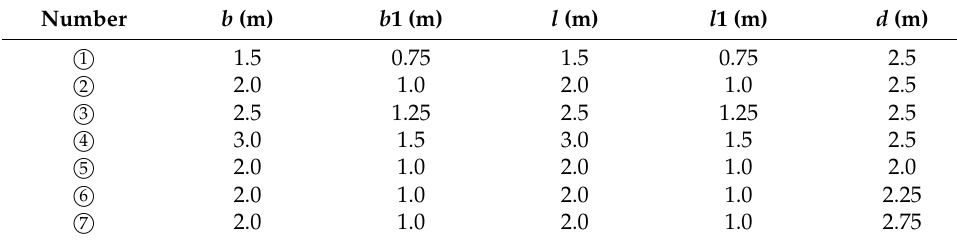
Table 5. Calculation parameters of the soil mass.